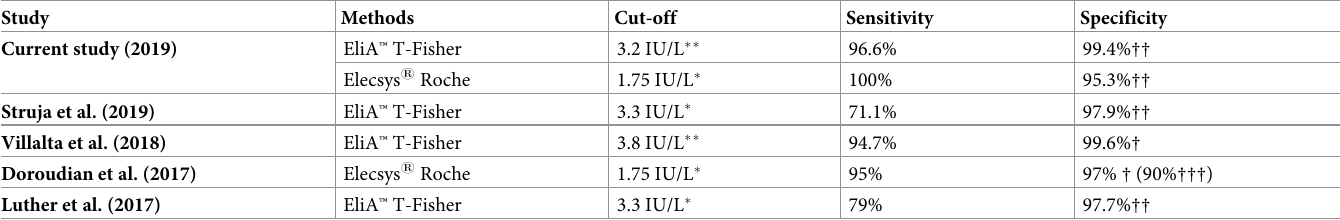
Table 4. Test performance values obtained from comparative studies for TRAb measurement methods including EliA ™ and/or Elecsys 1 evaluation.